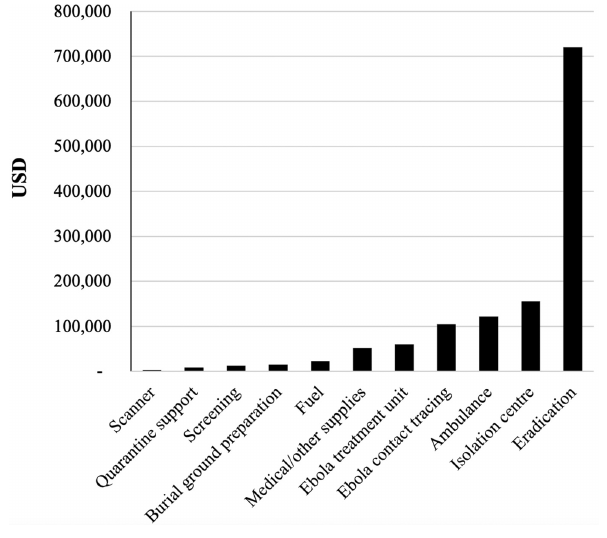
Figure 2 Costs of external support by